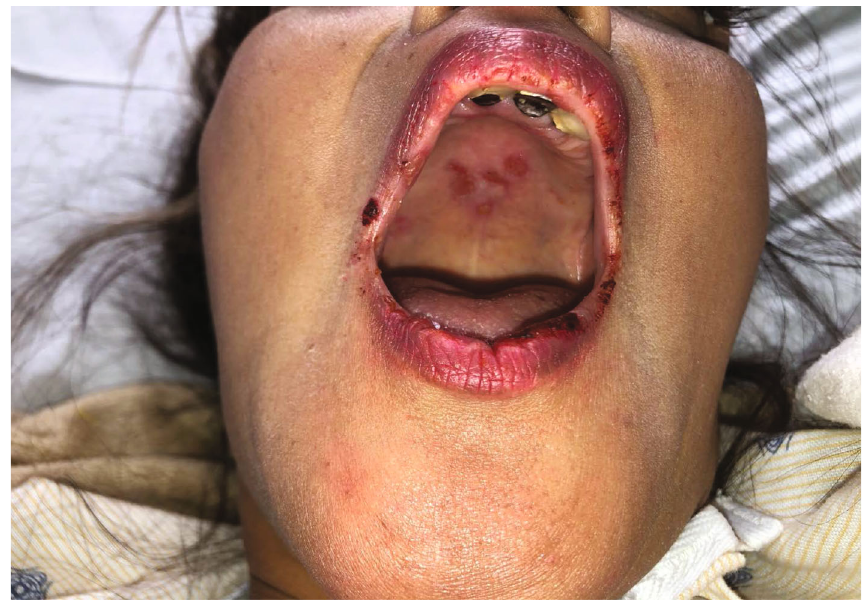
Figure 10: Involvement of the lips and palate in a case of bullous